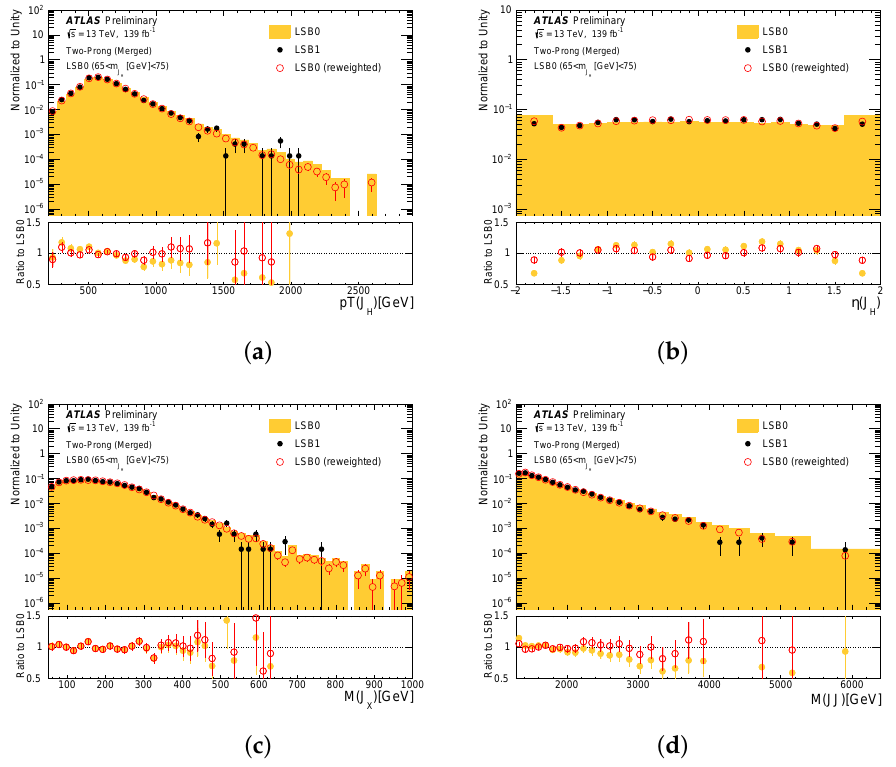
Figure 3. Distribution of the H candidate p T ( a ) and η ( b ), along with the mass of J X ( c ) and m Y ( d ) in the merged LSB validation region, overlaying data from LSB1 with the data in LSB0 shown before (orange) and after (red) reweighting. The ratio of the LSB1 data to both the LSB0 data (orange) and the reweighted LSB0 data (red) is shown in the lower panel. Error bars indicate statistical uncertainties